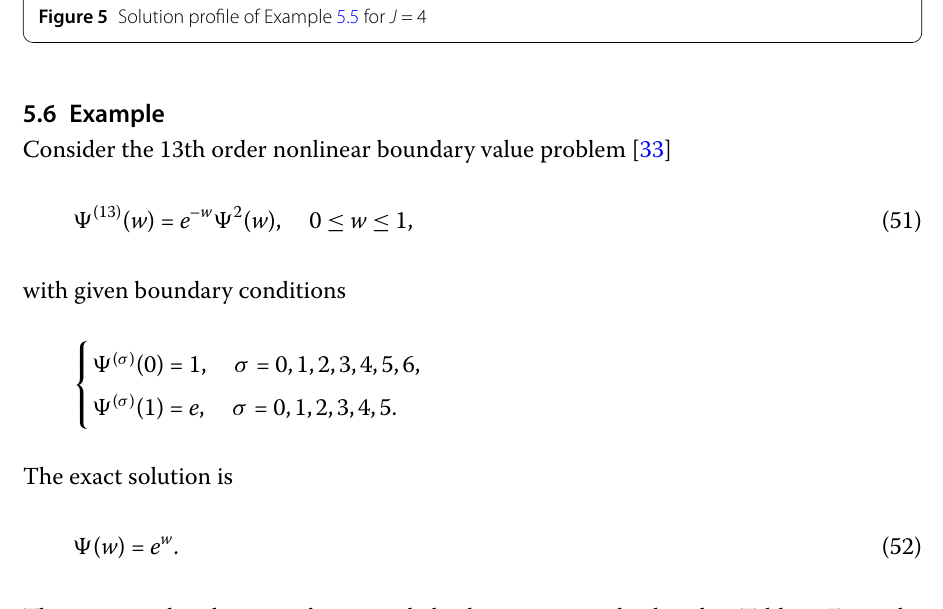
Figure 5 Solution profile of Example 5.5 for J =